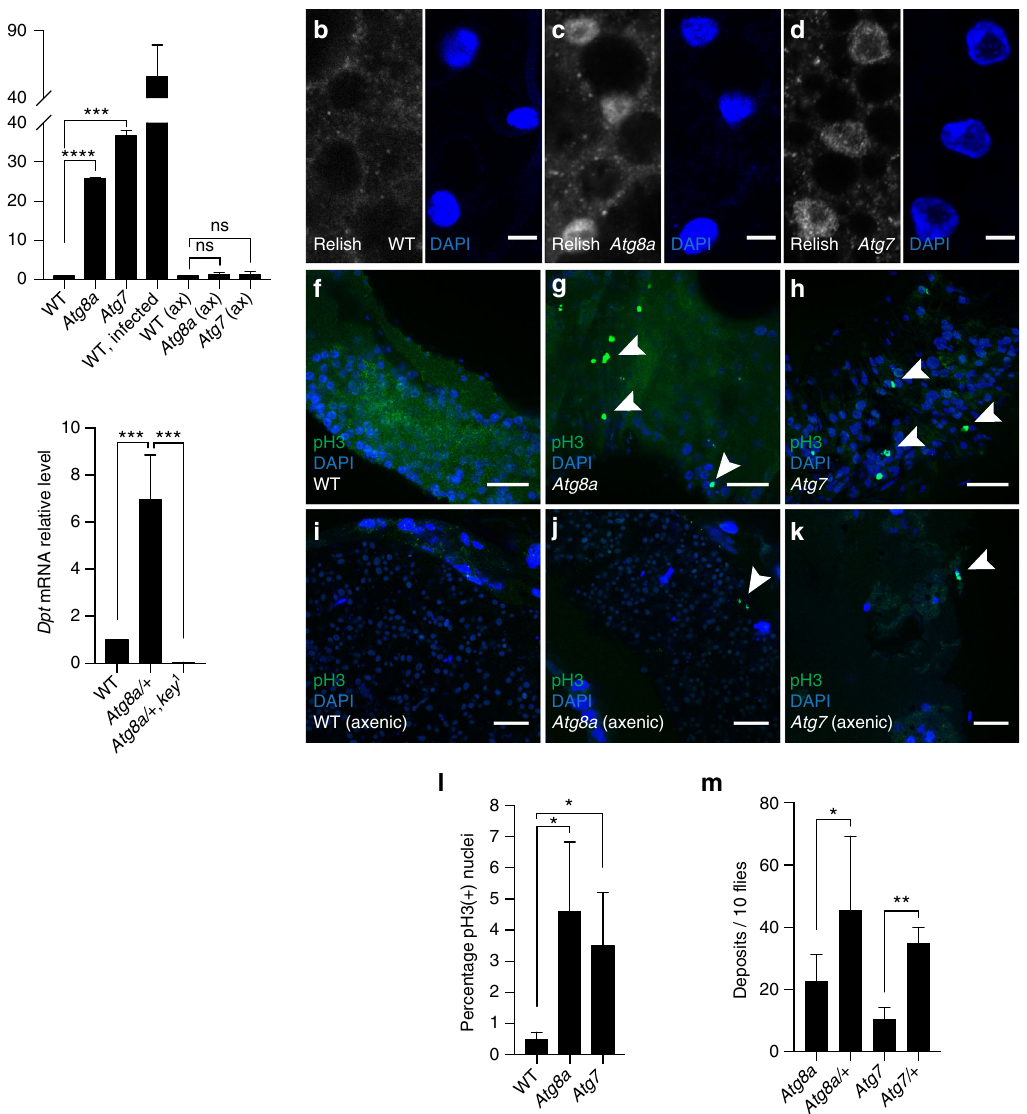
Fig. 8 Deregulation of the IMD pathway and intestinal dysplasia in autophagy-de fi cient fl ies is induced by commensal bacteria. a Analysis of Dpt mRNA levels in fl ies reared in conventional or axenic conditions. b – d Confocal images of fat bodies from conventionally reared wild-type b , Atg8a c and Atg7 d mutant adult fl ies stained for Relish (gray) and nuclei (blue). Scale bars are 5 µ m. e Analysis of Dpt mRNA levels in conventionally reared Atg8a/ Kenny double mutant fl ies. f – k Confocal images of posterior midguts stained for phospho-H3 (pH3, green) from wild-type f , i , Atg8a g , j and Atg7 h , k mutant fl ies reared in conventional f – h or axenic conditions i – k . Arrowheads show pH3-positive cells. Scale bars are 20 µ m. l Quanti fi cation of the percentage of pH3-positive cells per picture. m Quanti fi cation of the number of deposits per 10 fl ies. Bar charts show means ± s.d. Statistical signi fi cance was determined using one-way ANOVA, * P < 0.05, ** P < 0.01, *** P < 0.001, **** P <